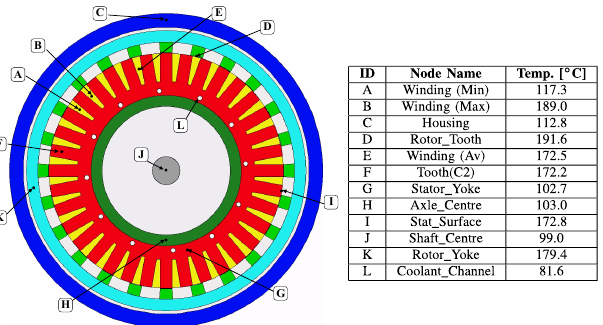
Figure 13. Steady-state temperatures in the radial cross-section of SRM at 1260 RPM and 1970 Nm.